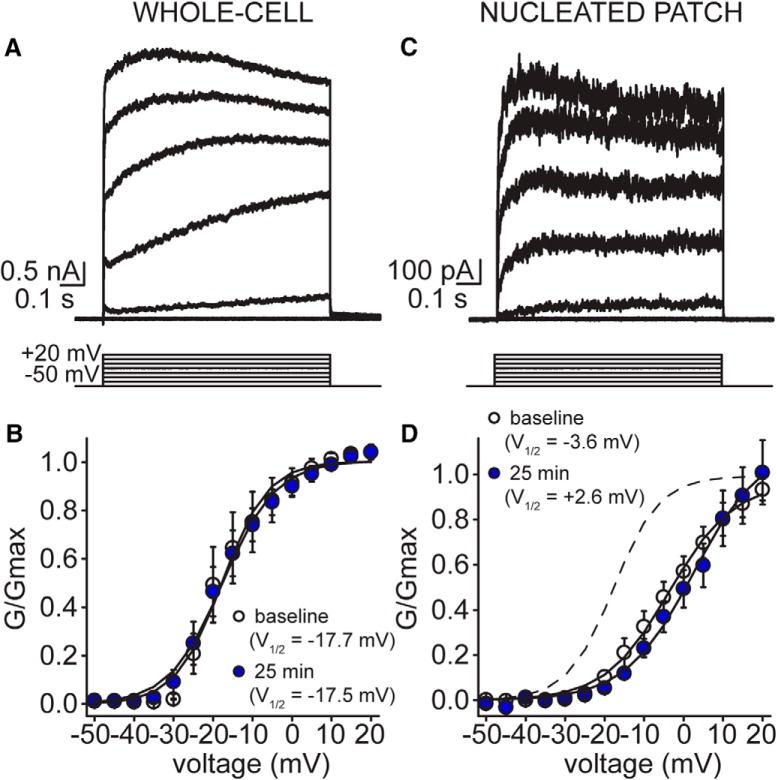

IK voltage dependence of activation remains stable over patch-clamp recording in both whole-cell and nucleated patch configurations. A, Example whole-cell voltage-clamp traces of delayed rectifier K+ current at baseline during activation protocol evoked from –50-mV holding potential (5-mV increments, up to +20 mV; patch #180521p2). B, Summary plot of voltage dependence of activation of delayed rectifier K+ current at baseline (white circles) and after 25 min of recording (blue circles; n = 8 cells). C, Example voltage-clamp traces after excising a nucleated patch of delayed rectifier K+ current at baseline during activation protocol evoked from –50-mV holding potential (5-mV increments, up to +20 mV; patch #180510p3). D, Summary plot of voltage dependence of activation of delayed rectifier K+ current at baseline (white circles) and after 25 min of recording (blue circles; n = 6 cells). Dashed line depicts baseline activation curve measured in whole-cell configuration from B.